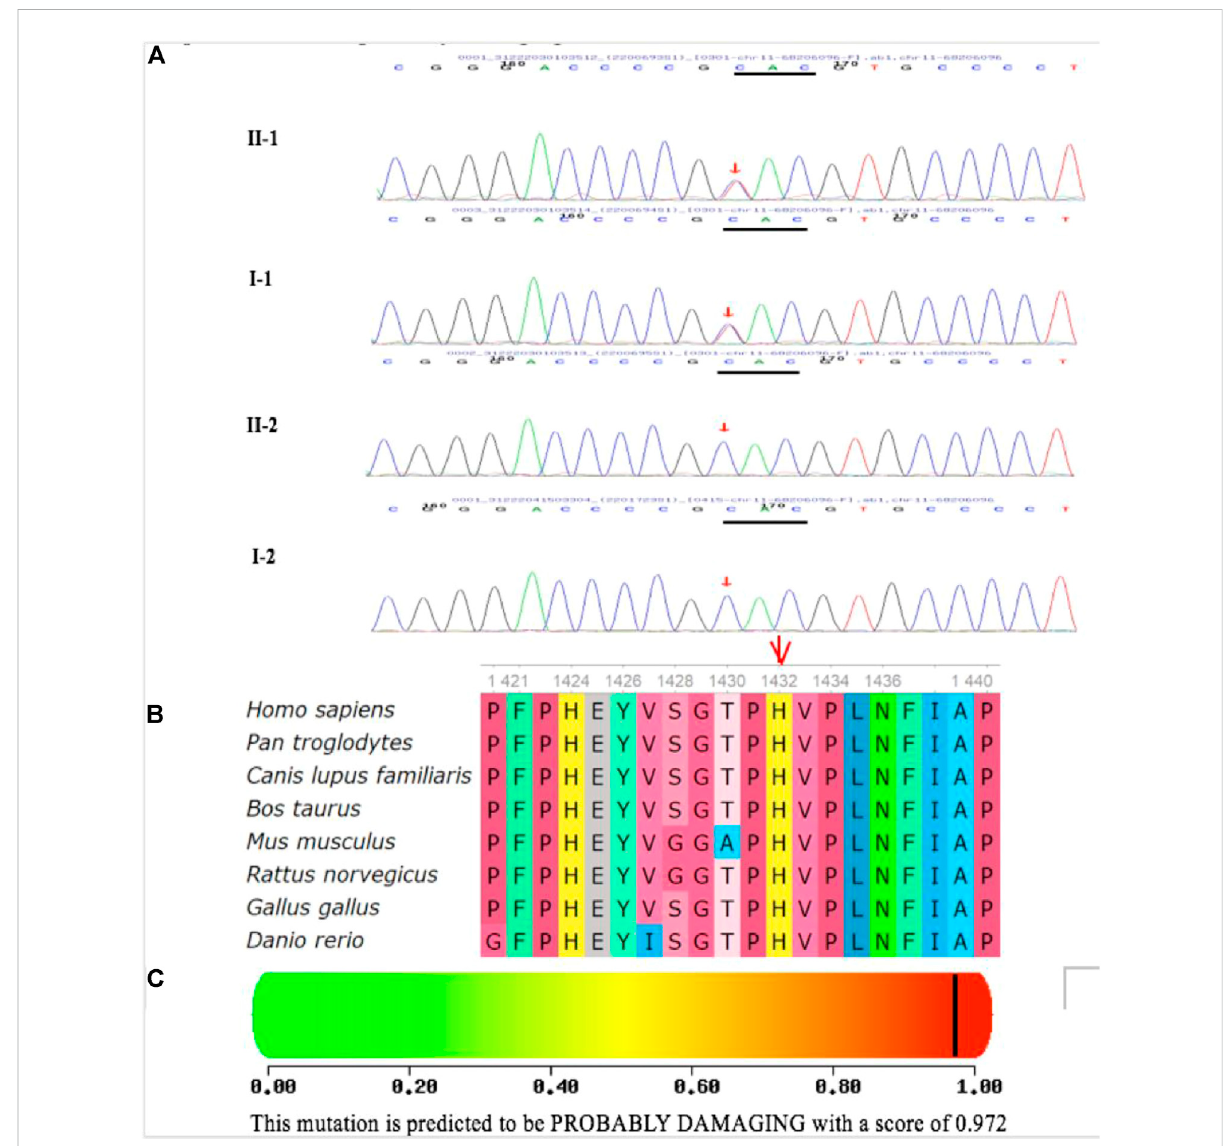
FIGURE 10 Identi fi cation of one heterozygous LRP5 mutation in the family members. (A) DNA sequence chromatograms of the unaffected and affected family members. One heterozygous LRP5 mutation c.4294C > T ( p .H1432Y) in exon 20 was identi fi ed in the cases of the proband and his father. (B) Multiple-sequence alignment of the LRP5 proteins from different species. The red triangle indicates the location of the mutation. The His 1432 residue is highly conserved across species. (C) Polymorphism Phenotyping predicted that the amino acid substitution H1432Y in the protein LRP5 is probably